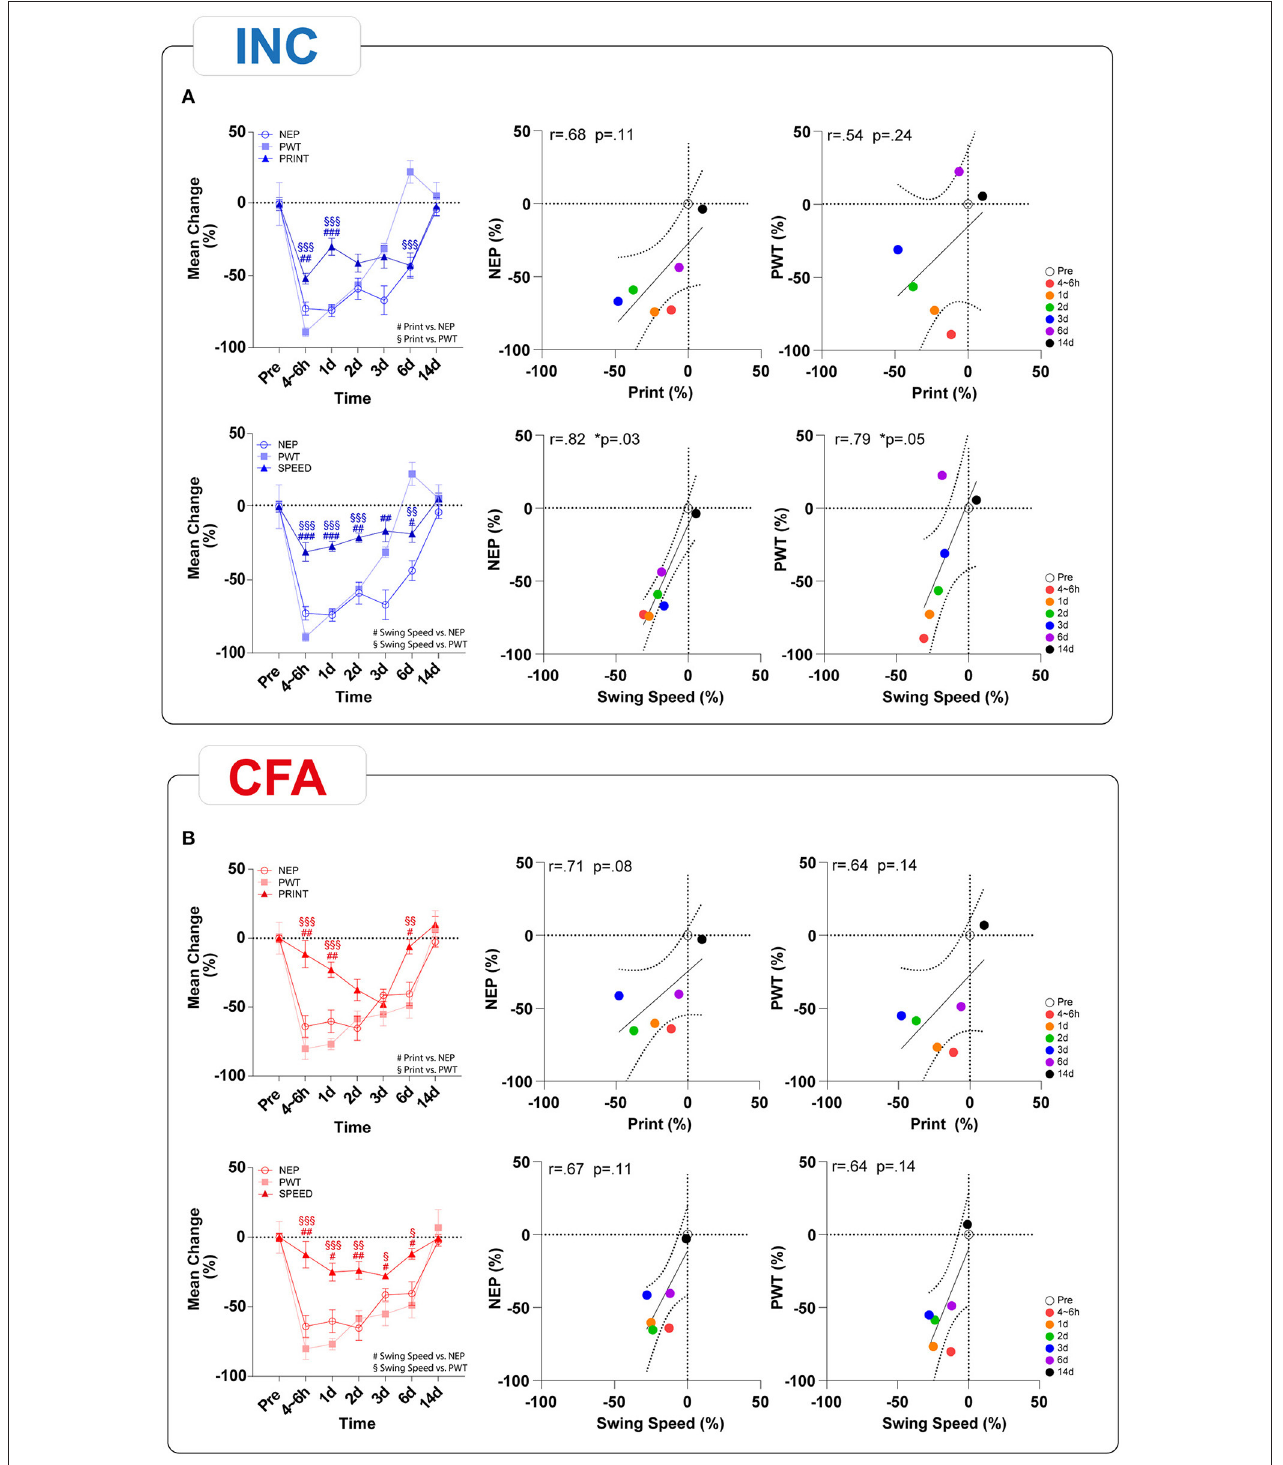
FIGURE 7 | Time-dependent correlation analysis of static and dynamic gait parameters with NEP behavior and mechanical thresholds in INC (A) and CFA (B) animals. Upon INC, significant correlations were observed for the dynamic gait parameter “Swing Speed” with NEP and PWT. Neither the static parameter “Print” in the INC group nor all comparisons of CFA group, significant correlations could be found. Linear regression (solid line) with 95% CI (dotted line) is displayed. Values of p : * p < 0.05, ** p < 0.01, *** p < 0.001 by Spearman (two-tailed) coefficients were used to determine relationships between multiple parameters. Correlation analyses were performed after first computing the mean of side-by-side replicates and then analyzing those means.